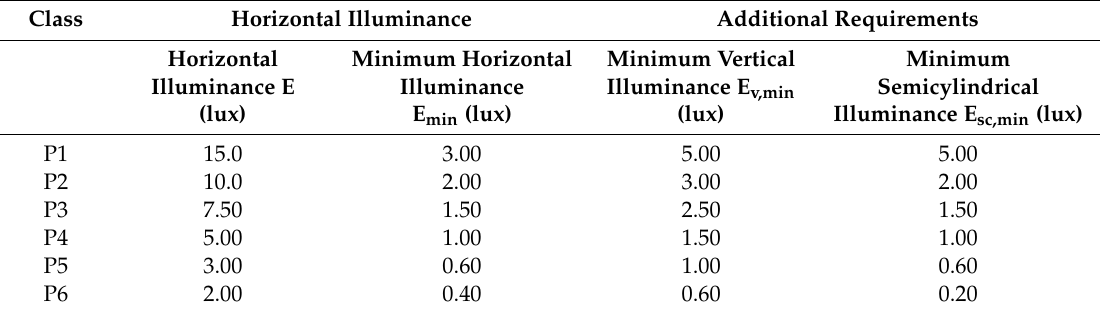
Table 2. P lighting classes from EN 13201-2 [37].